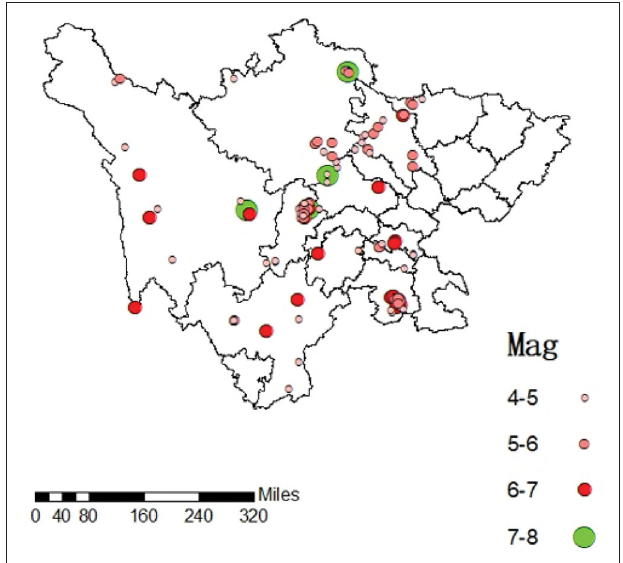
FIGURE 1 | Earthquake distribution map of Sichuan